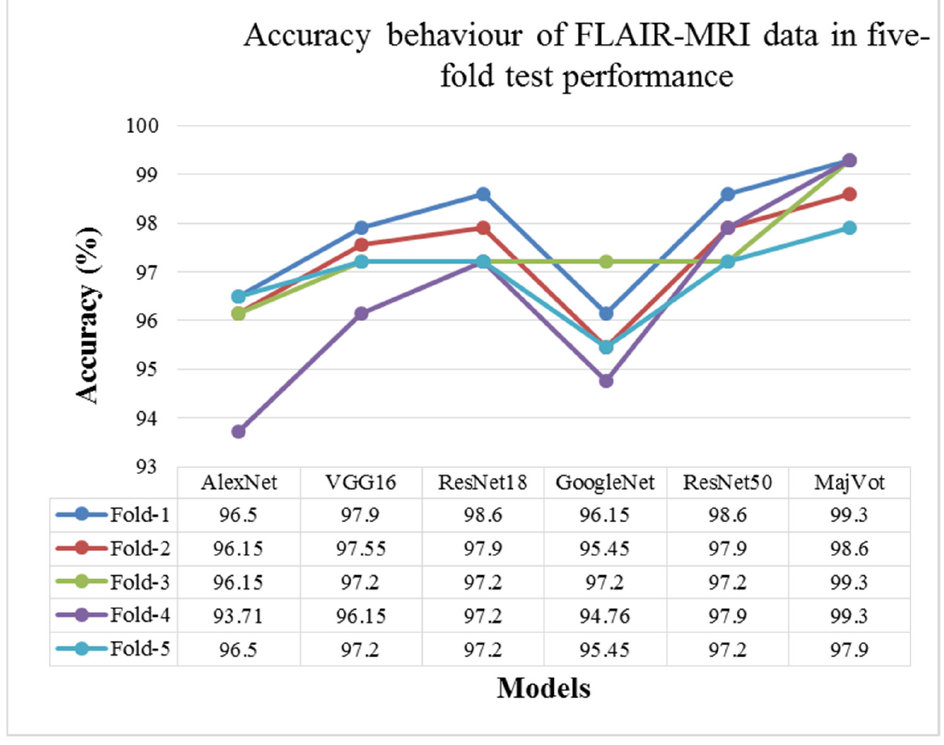
Figure 12. Model-wise accuracy behavior in the five-fold test performance of FLAIR-MRI data.